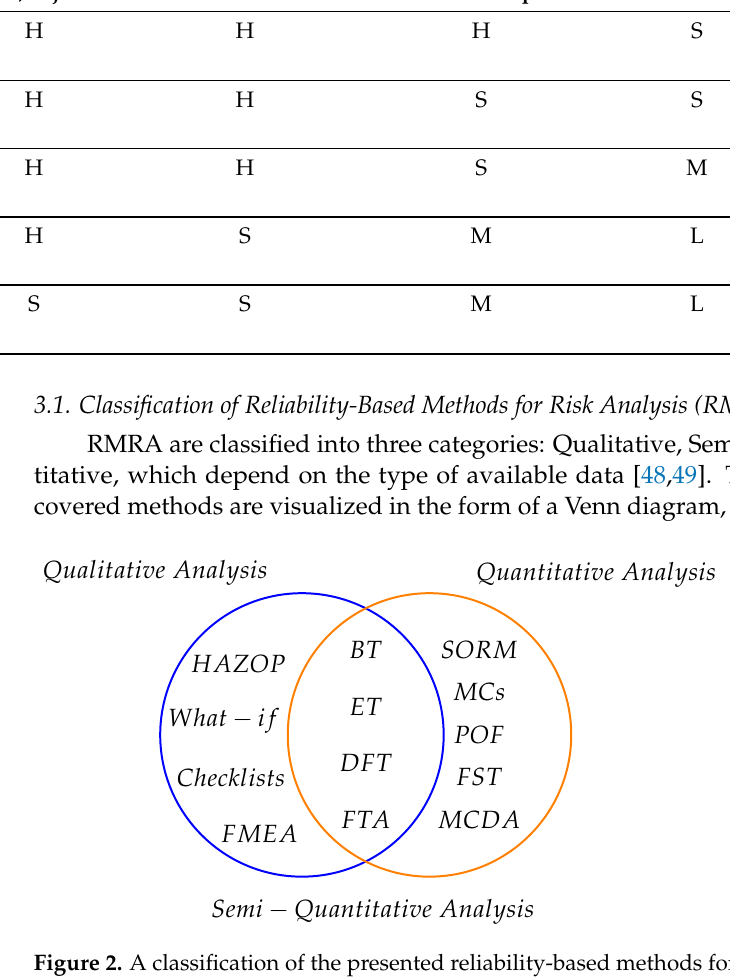
Figure 2. A classification of the presented reliability-based methods for risk